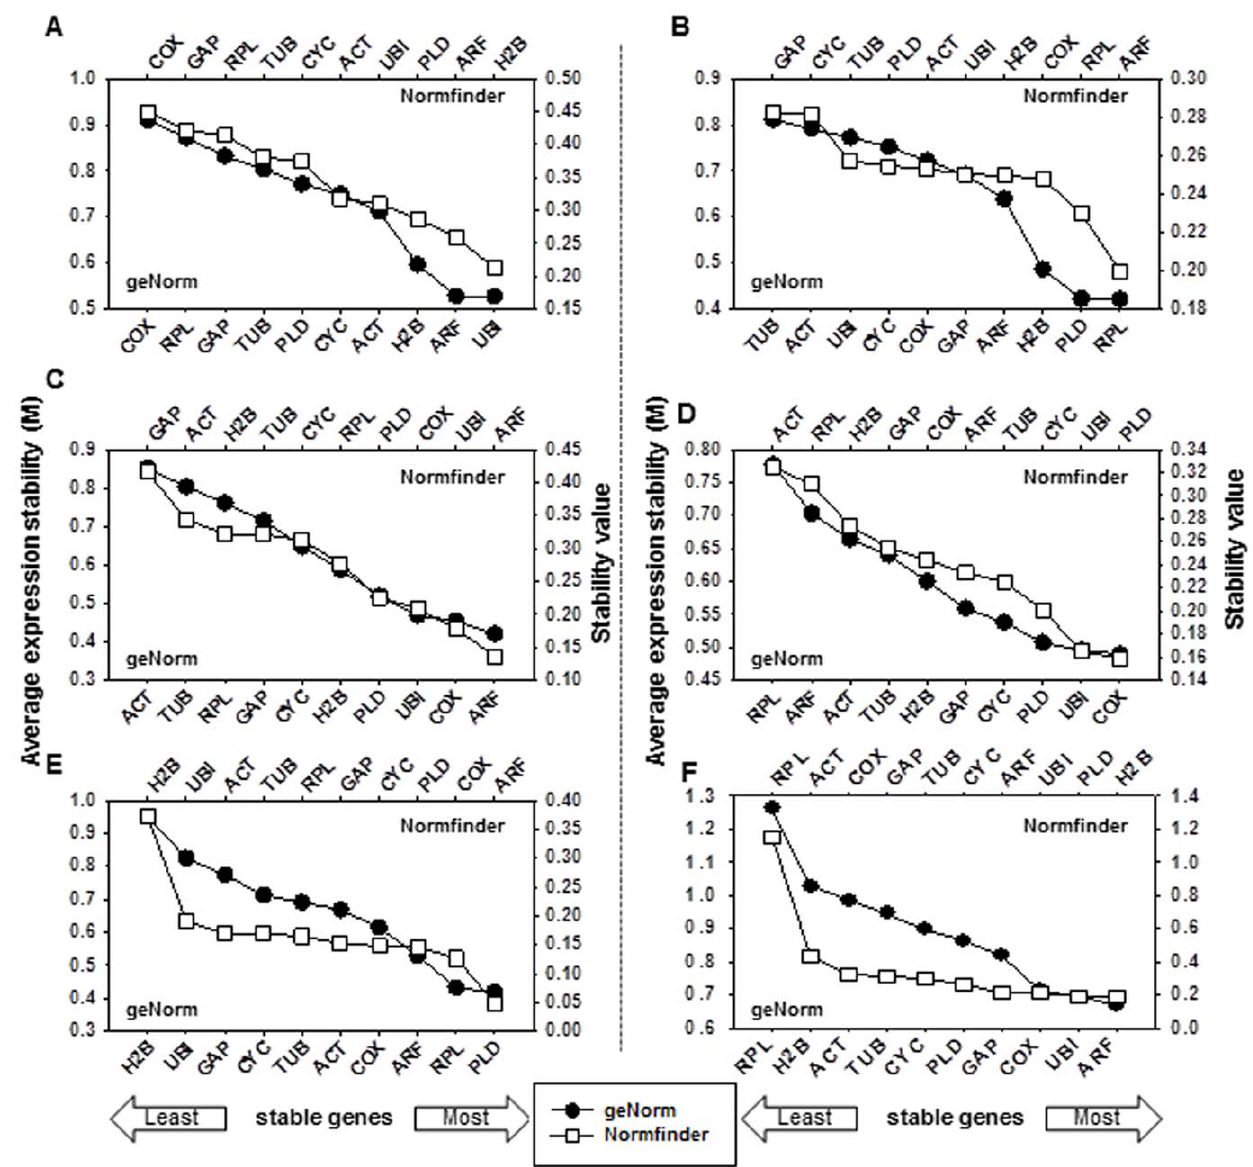
Figure 2. Average expression stability values ( M ) and the stability values in different data sets obtained from the software geNorm and NormFinder, respectively. (A) Cold stress, (B) oxidative stress, (C) salt stress, (D) drought stress, (E) tissues, and (F) total.